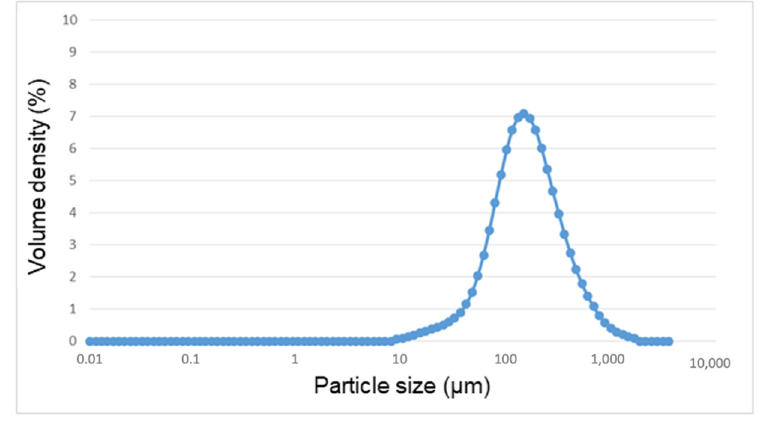
Figure 1. Distribution of particle size of the metal debris after implantoplasty. Table 2. Granulometry results of the Ti6Al4V powder.